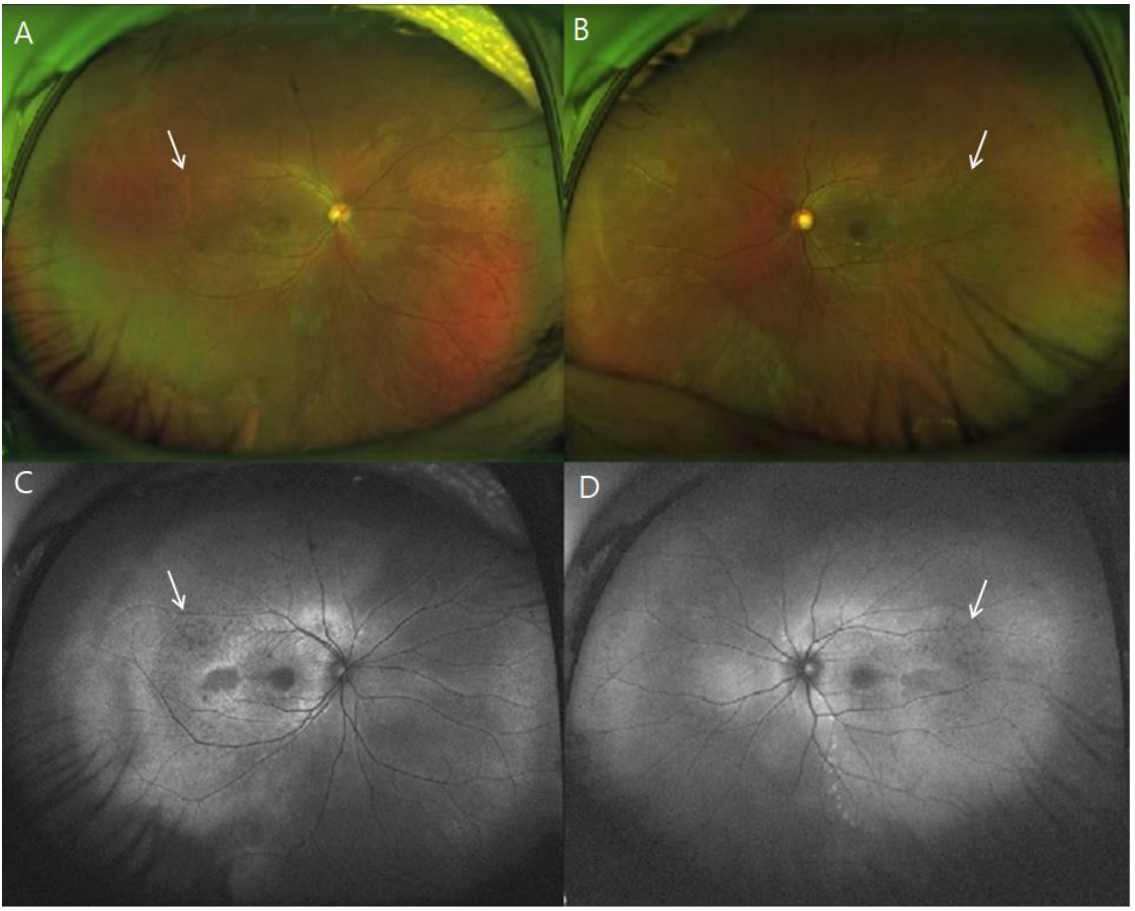
Figure 2. Widefield images of a 33-year-old man (patient 2, p.Arg255Trp and p.Ser79Phe mutation in BEST1 ). ( A , B ) Peripheral drusen-like materials (white arrows), presumed subretinal, are visible in widefield imaging, and appear hypofluorescent on widefield autofluorescence imaging ( C , D ). No evident peripheral retinal pigment epithelium atrophy was found.